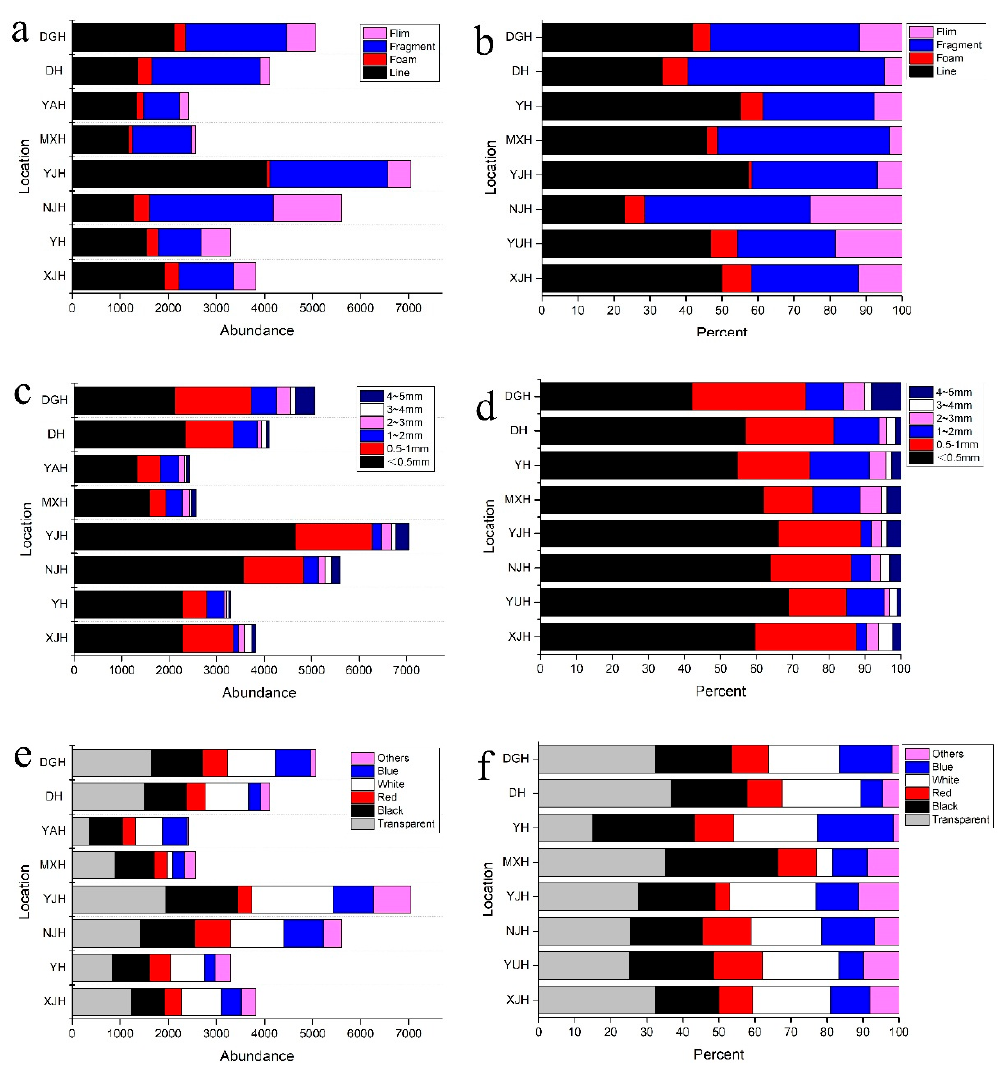
Figure 2. Abundance and proportion of ( a , b ) type distribution, ( c , d ) size distribution and ( e , f ) color distribution of microplastics collected from Changsha.